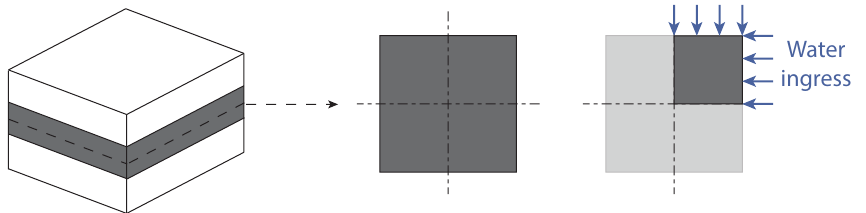
Figure 7. Numerical model developed for the gravimetric study of RJs with aluminum substrates, considering only water uptake through the adhesive.